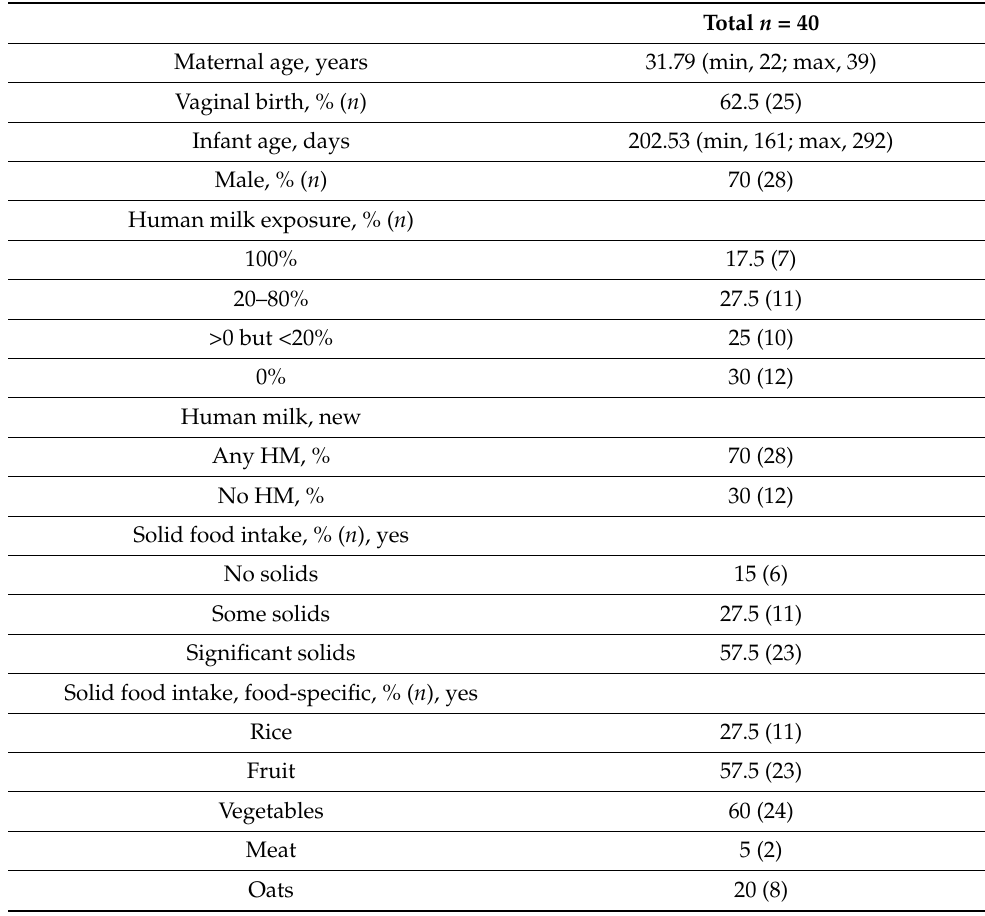
B. inf (Figure 1). Of those consuming human milk, 85.7% ( n = 24) were positive for Sia, while 96.4% ( n = 27) were positive for B. inf. Overall, 80% ( n = 32) of the infants were posi- tive for Sia, but in the samples from infants fed no human milk, Sia was either undetectable or slightly positive. Of the infants whose samples contained detectable levels of B. inf (95% ( n = 38)), 25% of those from the infants fed no human milk were very positive for B. inf whereas 54% of those from the infants fed human milk were very positive. Inf 2348 was detected in all the infant samples ( n = 40) while HC bin was detected in all but one sample ( n = 39). HH (haloacid dehalogenase-like hydrolase domain-containing protein) was detected in 92.5% ( n = 37) of the infants, Blon (major facilitator superfamily)—in 95% ( n = 38) of the infants. GH492 (glycoside hydrolase), GH750 (glycoside hydrolase), and Bbreve (16S) were detected in fewer infants—67.5% ( n = 27), 62.5% ( n = 25), and 57.5% ( n = 23) respectively. When we considered detection of the following five genes, Sia, GH492, Inf 2348, GH750, and HH, at a level that was “more positive” or “very positive,” we found that the stool of the human milk-fed infants harbored a more diverse set of HMO genes than that of the non-human milk-fed infants ( p = 0.0148). The stool samples from the human milk-fed infants contained a median of 2.5 of the five HMO genes whereas the samples from the non-human milk-fed infants contained a median of one HMO gene. Table 2. Participant